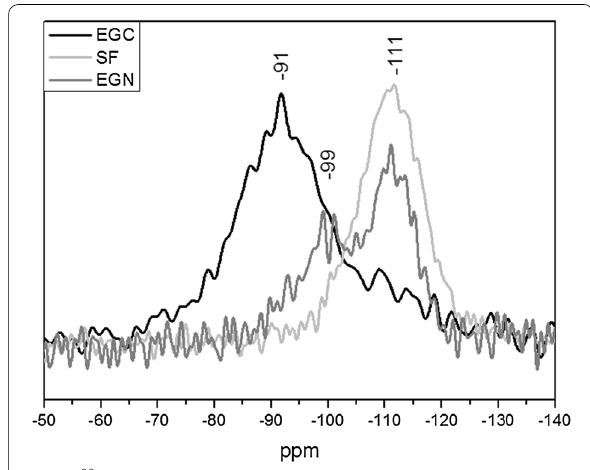
Table 2 Results of deconvoluting 29 Si NMR spectra for blended composites (%).